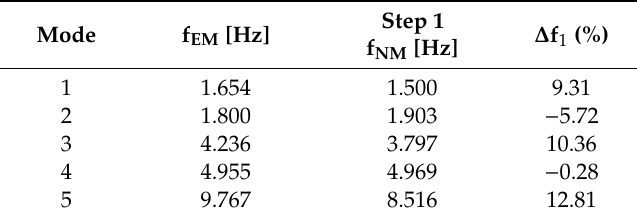
Table 2. Comparison between EM and NM frequencies at step 1.